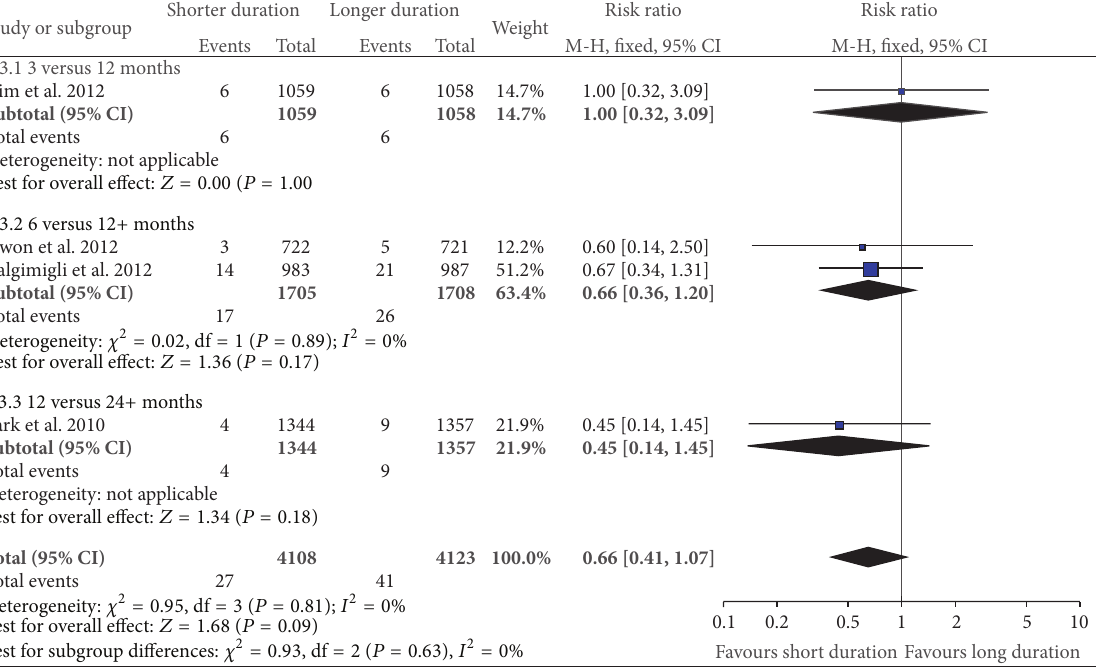
Figure 3: Risk of stent thrombosis, myocardial infarction, stroke, and